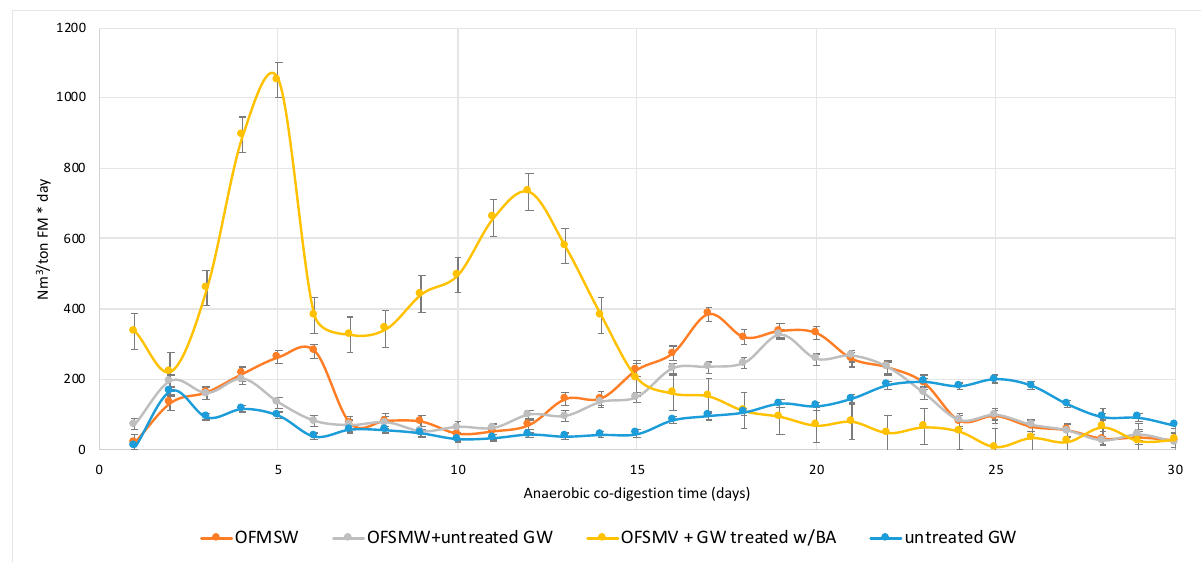
Figure 2. Daily production of biogas from the co-digestion of OFMSW and GW, treated with BA and untreated, compared with AD of the sole OFMSW and untreated GW. Since biogas production was collected discontinuously, the conjunction lines have the sole function of helping with the comprehension of daily trends and do not correspond to continuous measurements. OFMSW = organic fraction of municipal solid waste; GW = green waste; BA = Bjerkandera adusta ; AD = anaerobic digestion.